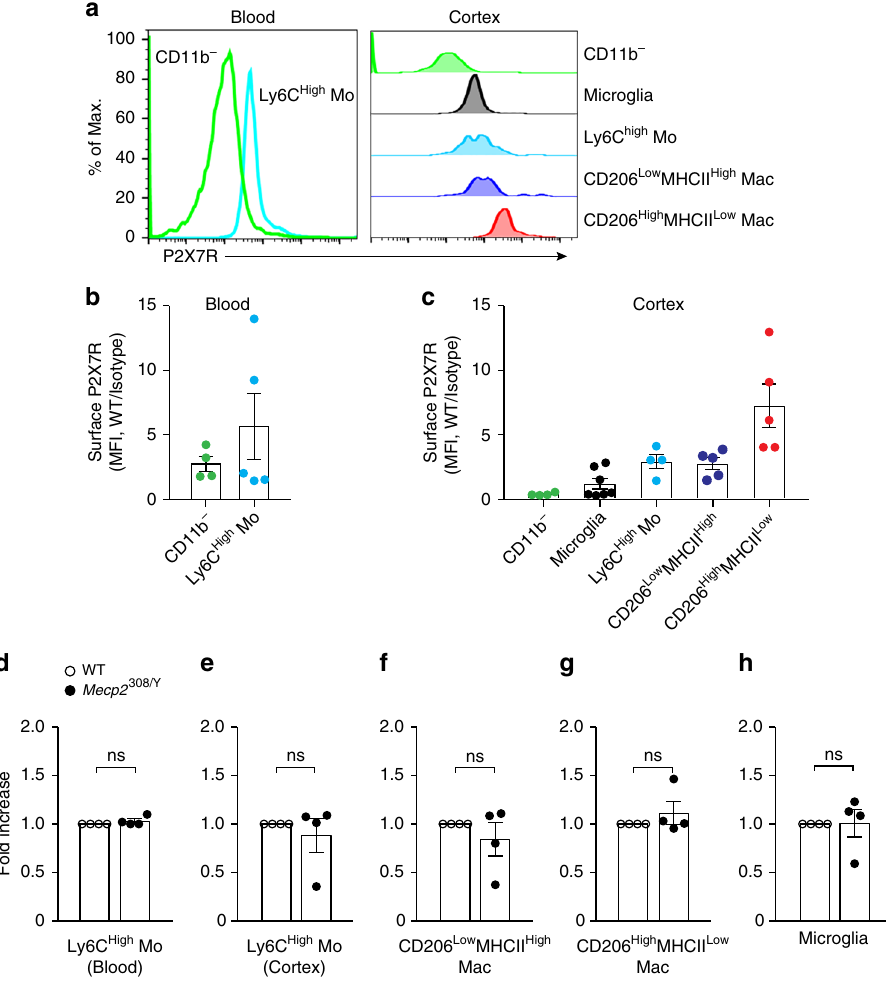
Fig. 2 P2X7Rs are abundantly expressed on monocytes and macrophages. a Histograms showing distribution of surface P2X7R expression in lymphocytes and Ly6C High monocytes in blood, and lymphocytes, microglia, monocytes (Mo) and macrophages (Mac) in the WT cortex. b , c Quanti fi cation of data shown in ( a ) in blood ( b ; n = 4, 5 mice) and cortex ( c ; n = 4, 7, 4, 5, 5). The median fl uorescence intensity (MFI) of cells stained with an anti-P2X7R antibody is normalized to the isotype IgG negative controls. P2X7R Low , P2X7R int , and P2X7R High are de fi ned as <2, 2 – 3, and >3 in MFI. d – h Surface P2X7R expression in blood Ly6C High monocytes d , cortical Ly6C High monocytes e , CD206 Low MHCII High macrophages f , CD206 High MHCII Low macrophages g , and microglia h of Mecp2 308/Y relative to WT mice ( n = 4 mice per group). Empty circle, WT; fi lled circle, Mecp2 308/Y . Unpaired two-tailed t test was used in ( d – h ). Summary data are presented as mean± SEM. The source data underlying b – h are provided as a Source Data fi